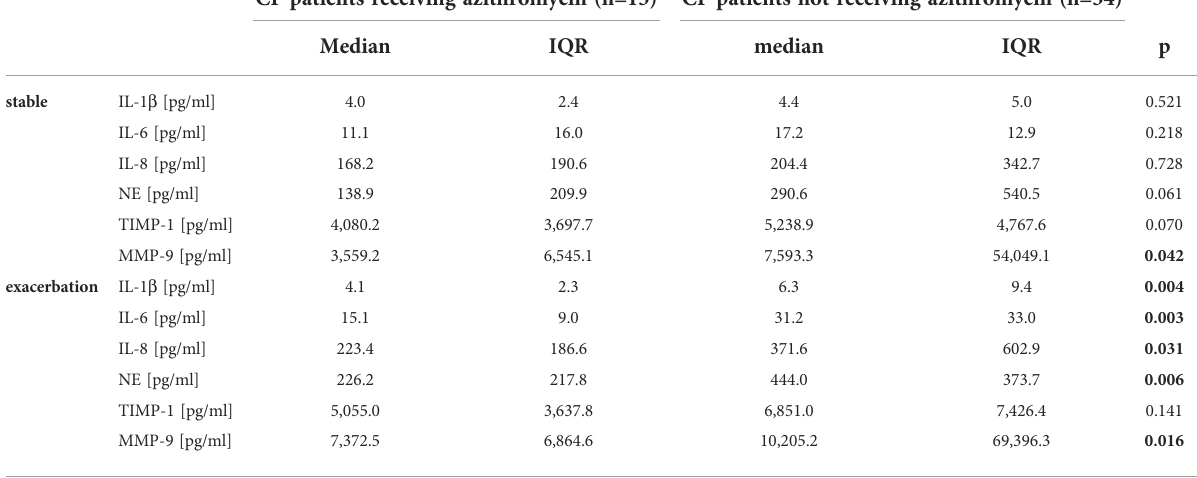
TABLE 3 In fl ammation markers in CF patients during stable phases and exacerbation in relation to oral medication with azithromycin.